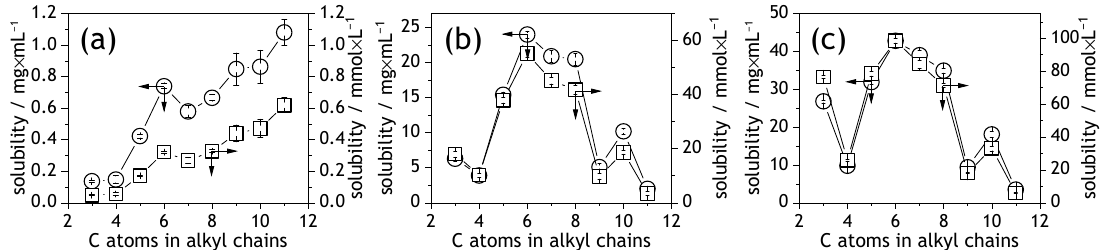
Figure 3. Solubility of NDIs in n-heptane ( a ), toluene ( b ), and 1,2-dichlorobenzene ( c ). Circles correspond to solubility in mg/mL (left axis). Square symbols indicate solubility in mmol/L (right axis).